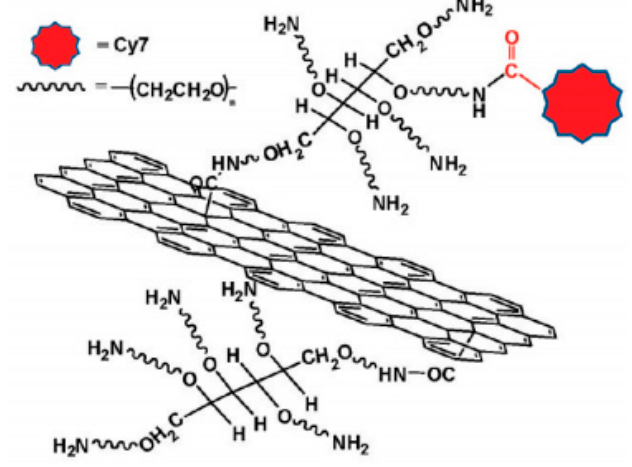
Figure 9. Graphene oxide (GO)-PEG-Cy7 nanoparticle design (obtained with permission from